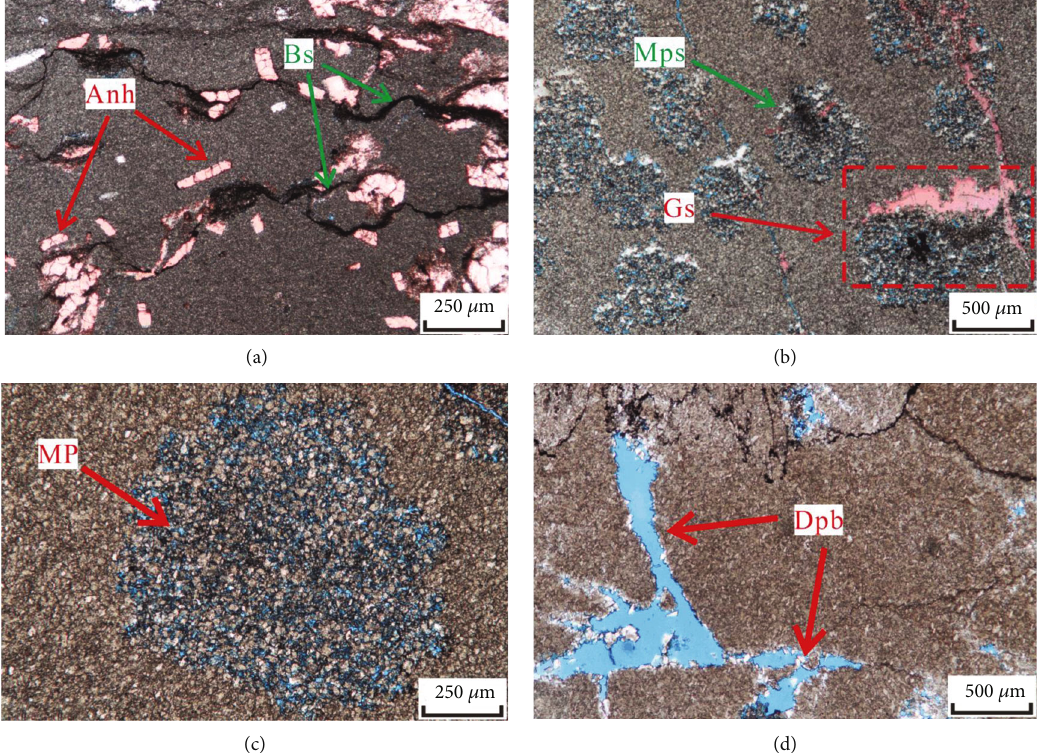
in the study area. 5